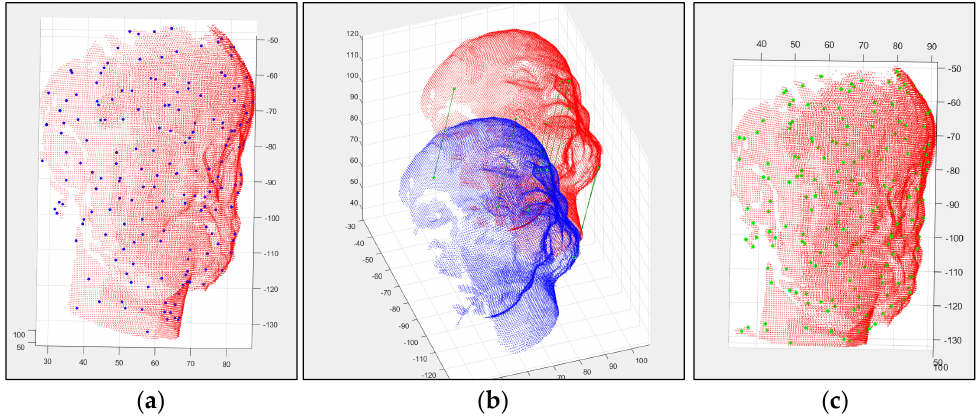
Figure 16. Aristotle sculpture: ( a ) the keypoints identified by ISS in the 1st point cloud; ( b ) match- ing two-point clouds with the ISS+PFH algorithm; ( c ) the keypoints identified by ISS in the 2nd point cloud. ISPRS Int. J. Geo-Inf. 2021 , 10 , x FOR PEER REVIEW